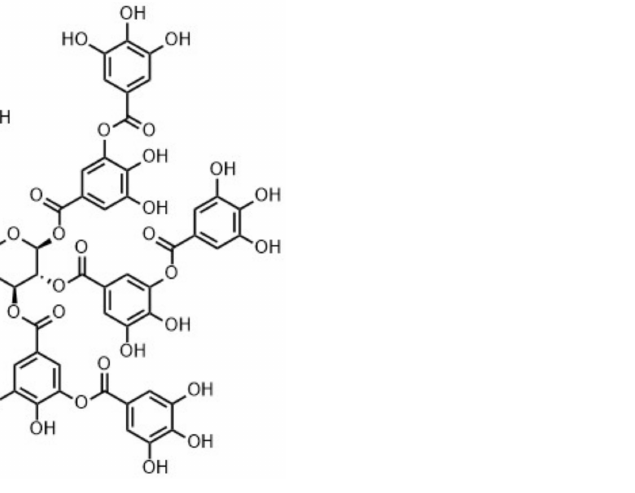
Figure 6. Structural representation of Tanal 01 ( Ta-01 ) and Tanal 02 ( Ta-02 ). Structural ‘impurities’ such as hellinoyl and flavogallonic acid are not indicated.